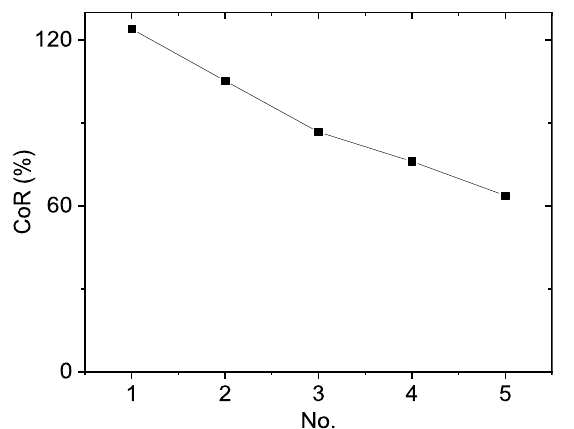
Figure 10 Change of the CoR for each collision